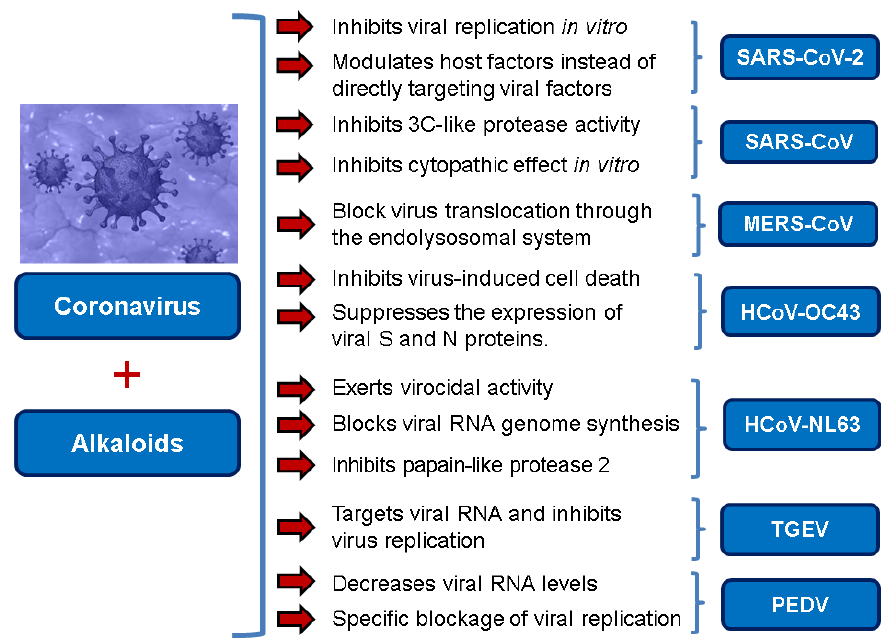
Figure 1. Main inhibitory actions of alkaloids against coronaviruses.